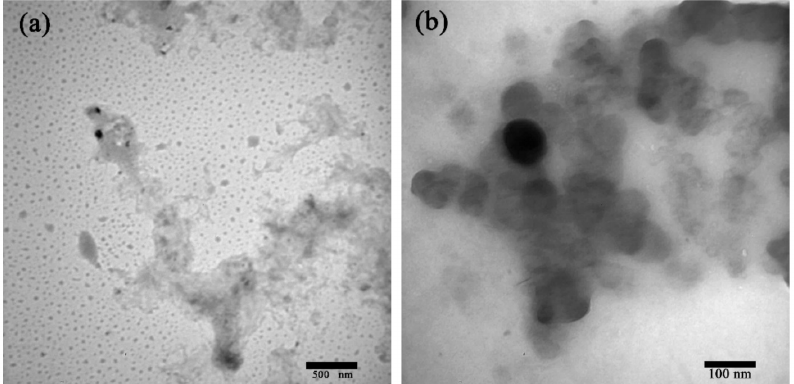
Figure 3. TEM image of the 1 wt% nano-copper modified low molecular weight PF resin when the scale bars are ( a ) 500 nm and ( b ) 100 nm, respectively.